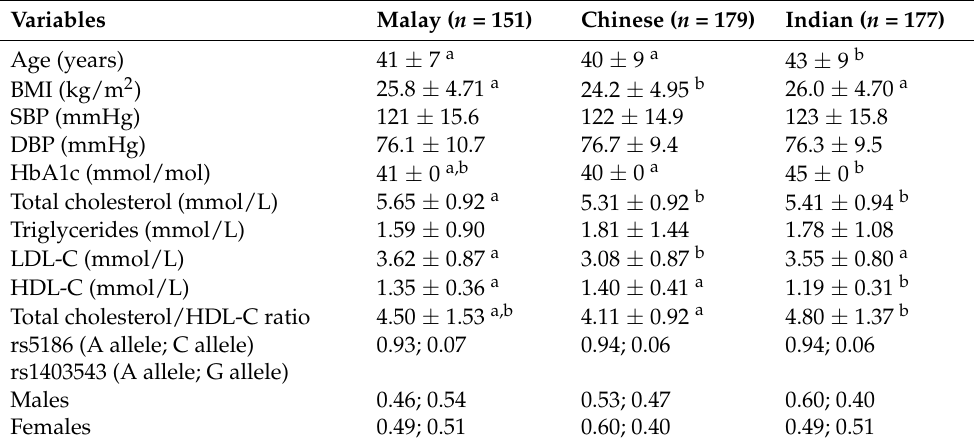
Table 1. Characteristics of the